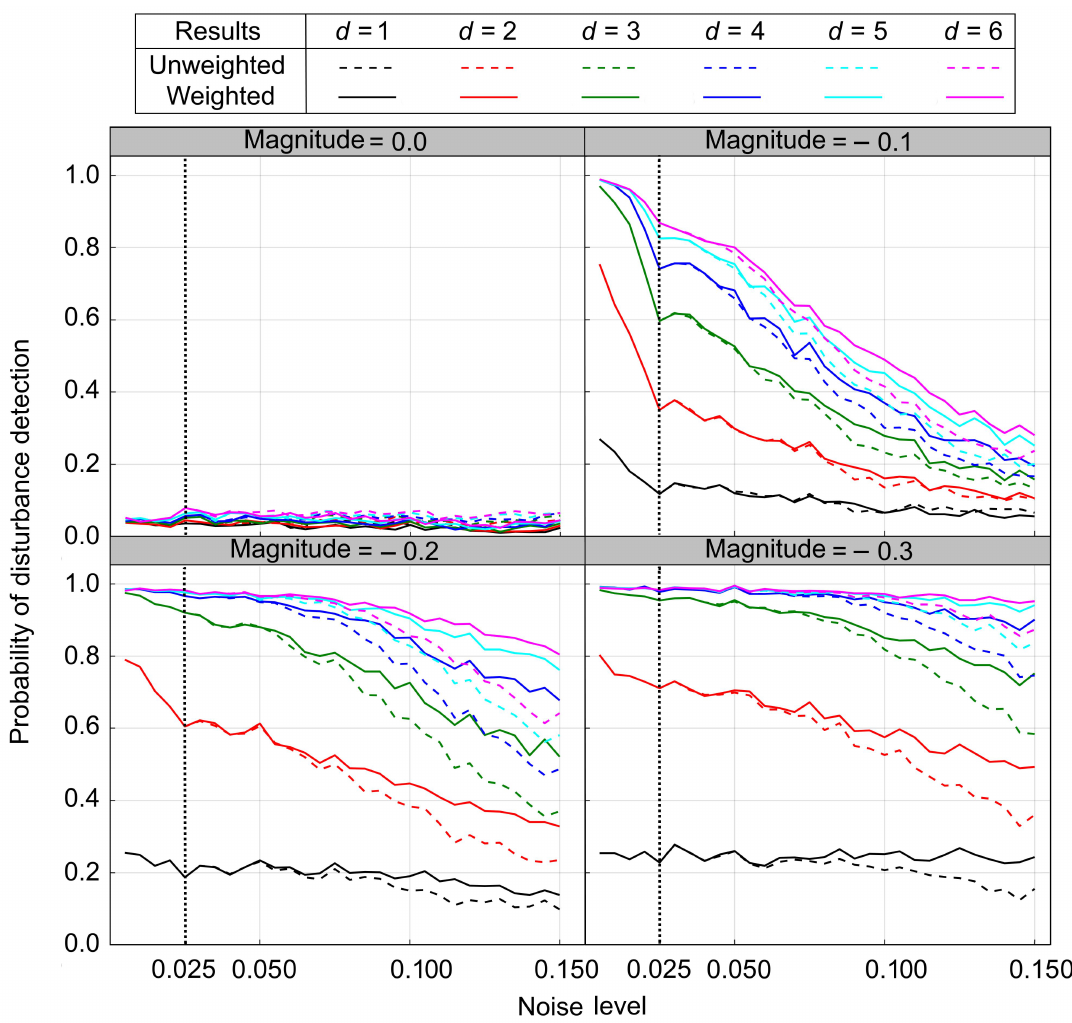
Figure 6. The probability of change detection ( y -axis) against the noise level ( x -axis) for magnitudes listed in Table 2. The weights are defined and considered after noise level 0.025 (see vertical dashed lines). The results of the weighted and unweighted methods for each d are shown by solid and dashed lines, respectively. The top left panel represents the method specificity, and the other three panels represent the method sensitivity. In general, the results of the weighted method show significantly higher true-positive and true-negative rates than the results of the unweighted method as the noise level